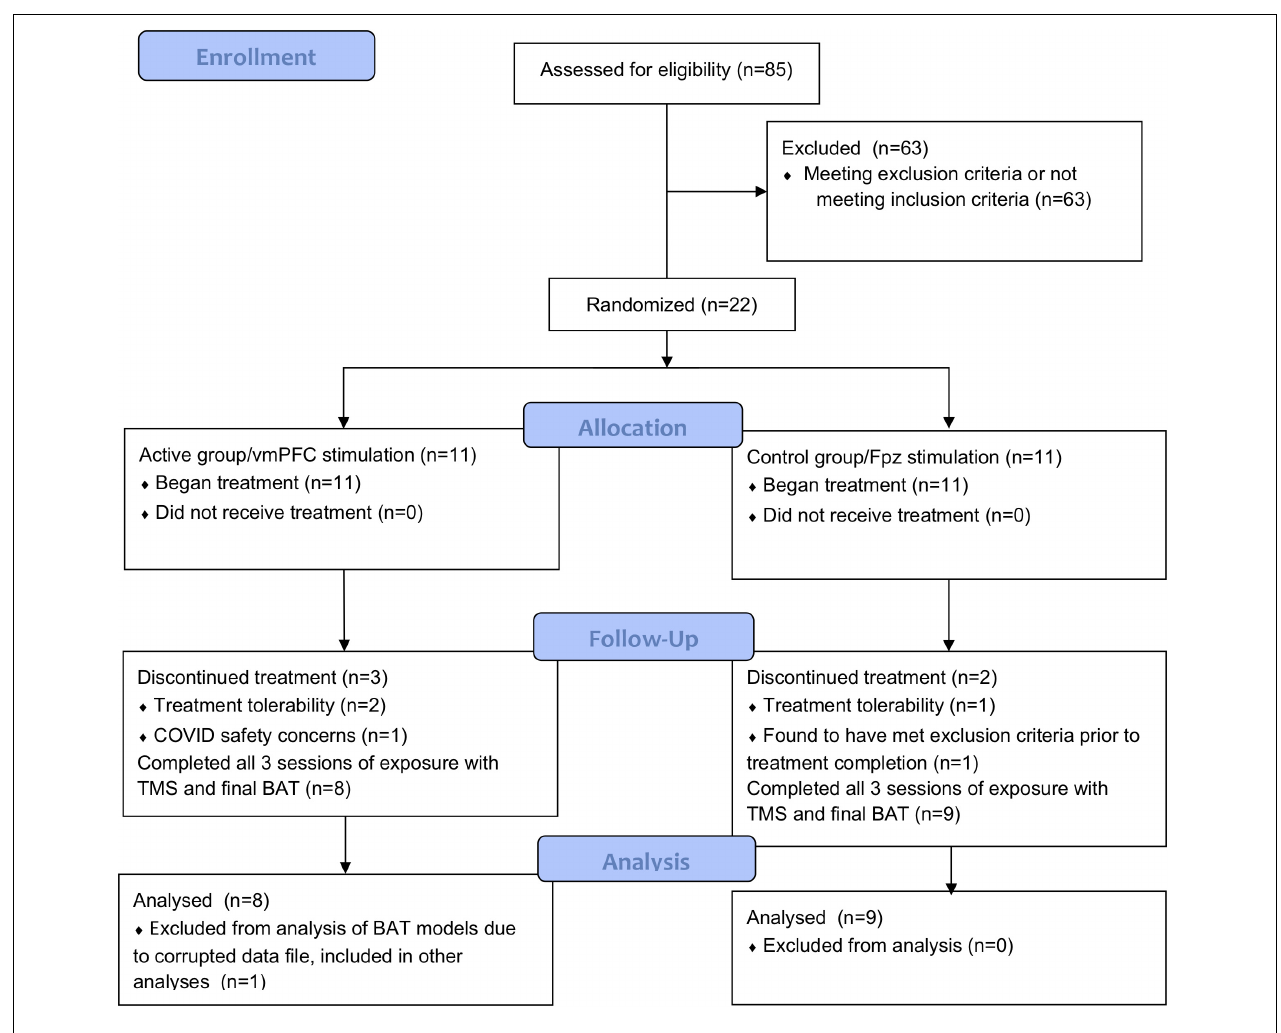
FIGURE 3 | CONSORT flow diagram of the described